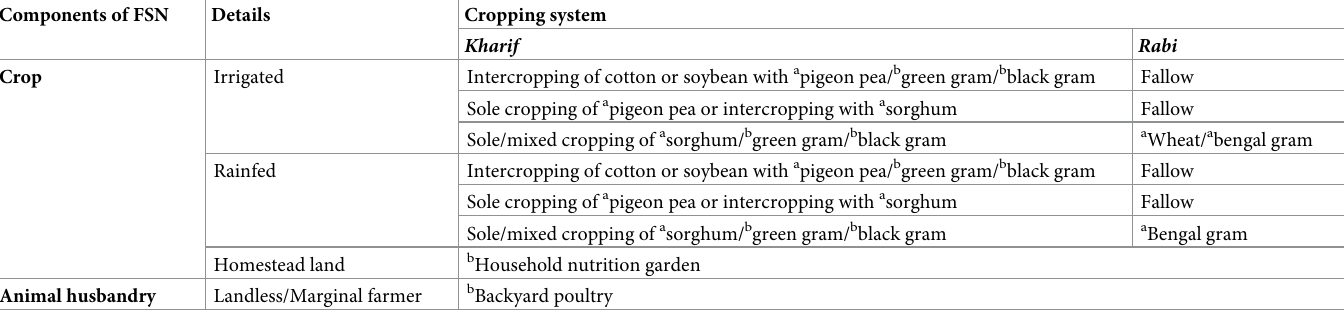
a indicates interventions where varietal replacement in combination with improved package and practices were followed for improved production b indicates interventions introduced for nutrient rich diversified